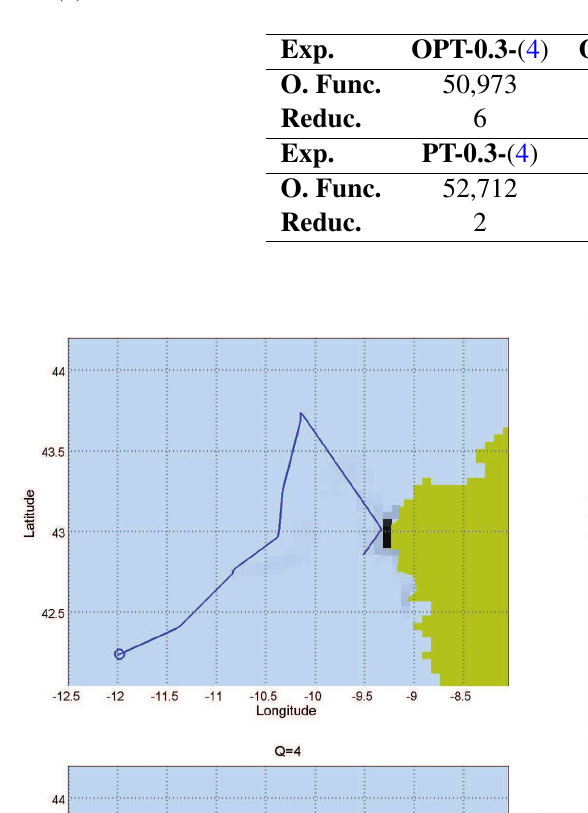
Table 3 Objective function (4) value ( O. Func. ) expressed in tons of oil and the percent reduction ( Reduc. ) of this value regarding the scenario Q =0 given by the experiments ( Exp. ): OPT-0.3- (4), OPT-4- (4), OPT-8- (4), PT-0.3- (4), PT-4- (4) and PT-8- (4) .